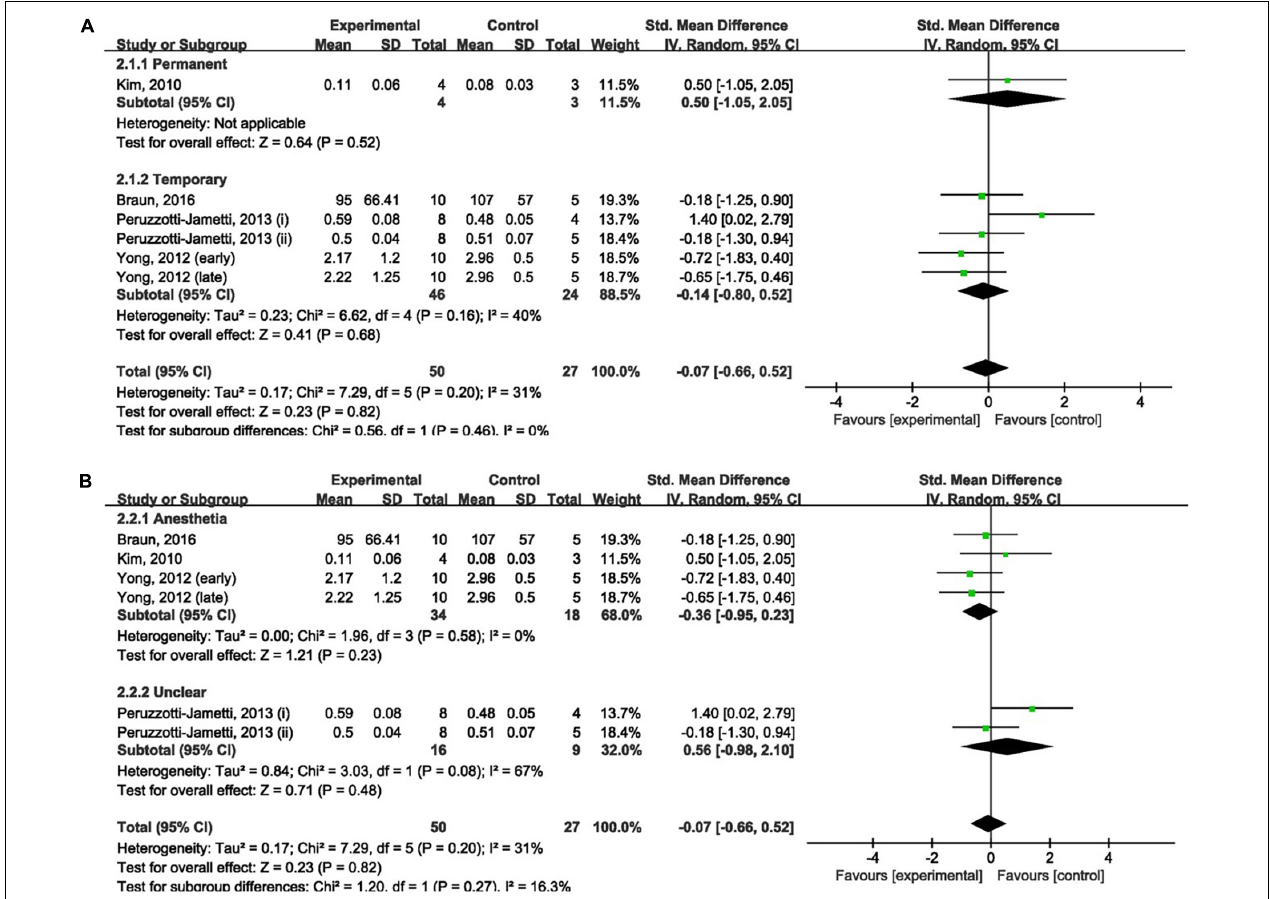
FIGURE 2 | Forest plot analysis of the efficacy of anodal tDCS on infarct size compared to controls divided on: (A) duration of ischemia; (B) anesthesia used during tDCS